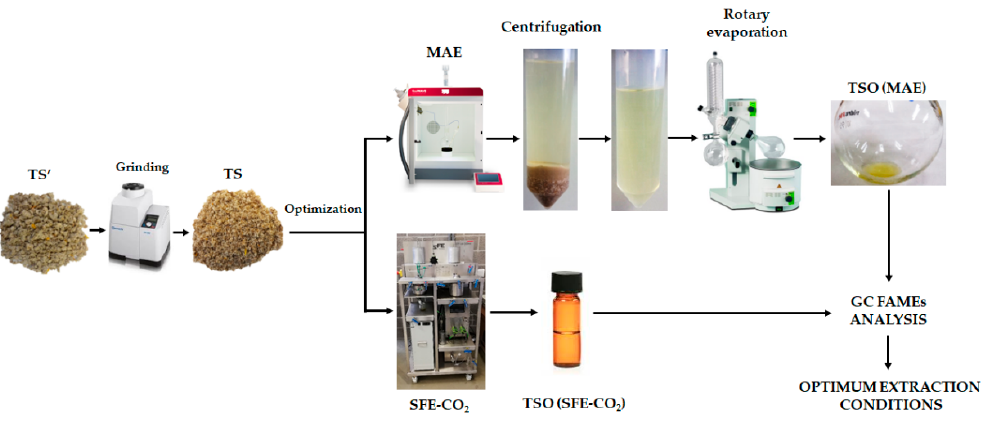
Figure 1. General scheme of fatty acids extraction optimization by microwave-assisted extraction (MAE) and supercritical fluid extraction (SFE-CO 2 ).